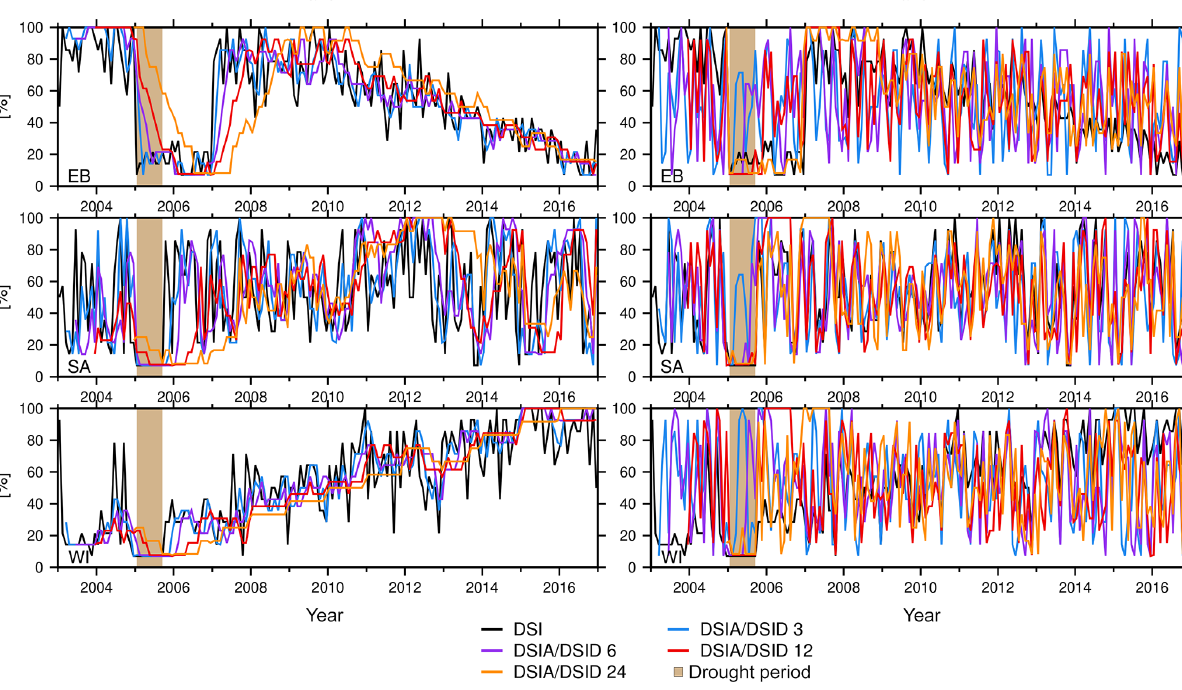
Figure 7. A representative example of the synthetic DI, DIA, and DID (%) for the eastern Brazil (EB), southern Africa (SA), and western India (WI) cluster over the periods of 3, 6, 12, and 24 months. Light brown shows the synthetic constructed drought